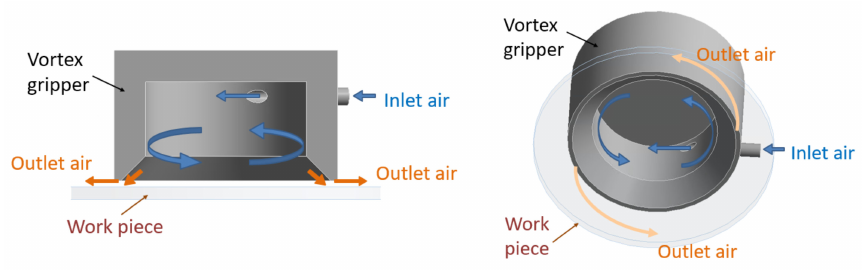
Figure 1. Vortex